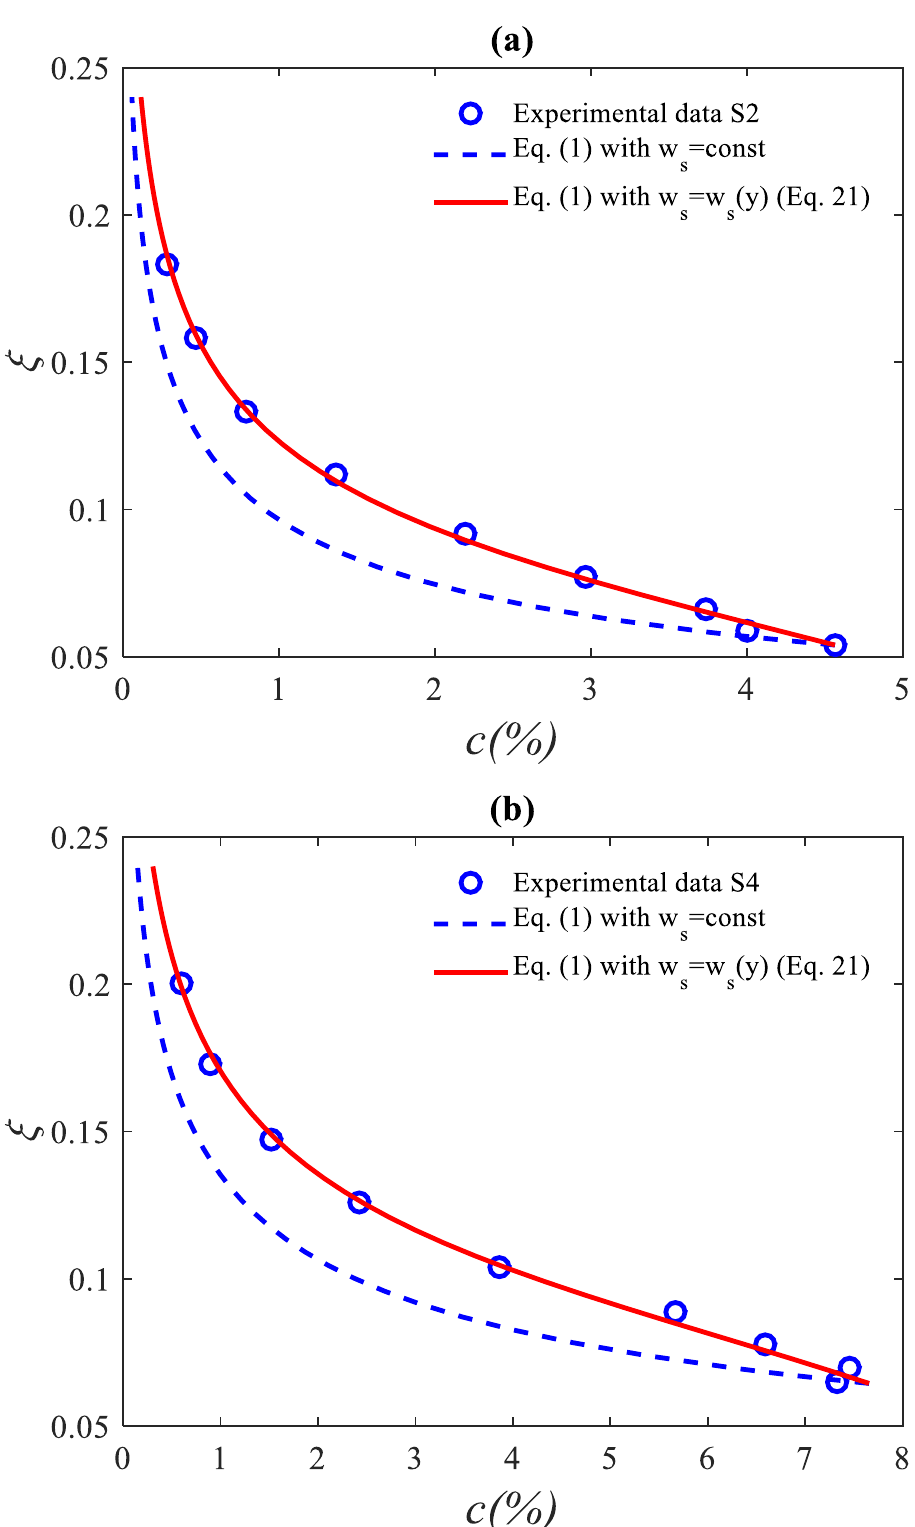
Figure 5. Concentration profiles for coarse sediments. Curves from numerical resolution of ADE (1) with ε s = ν t (5) C α = 0.477 and C 1 = 2.17; dashed lines: constant settling velocity ω s = ω s 0 = 0.1411m/s ; solid lines: 𝜔 𝑠 (𝑦) = 𝜔 𝑠0 𝑓 𝑠 (𝑦) (21); symbols: experimental data (a) S2 𝛼 𝑠 = 32 , ℎ 𝑠 = 0.019 ; (b) S4 𝛼 𝑠 = 70 , ℎ 𝑠 = 0.019 .